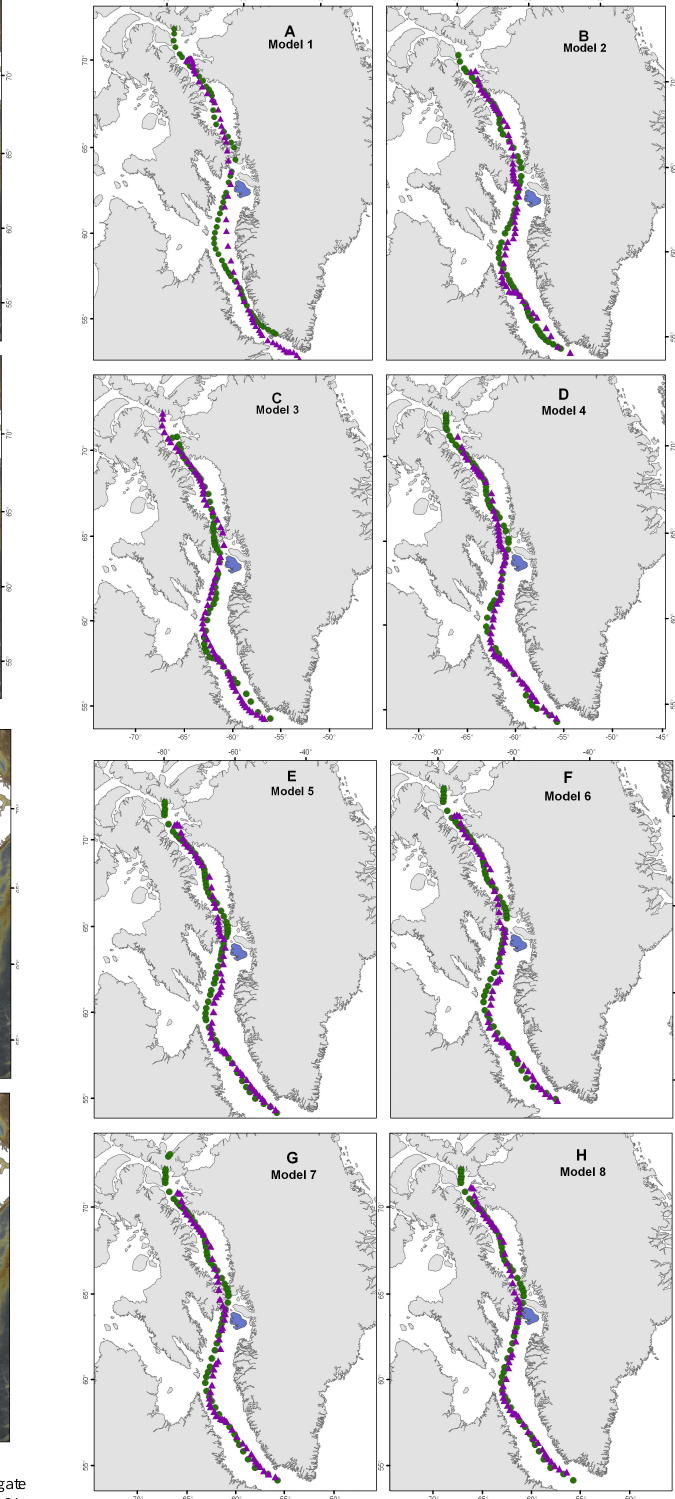
Fig. B2. Alternative full-fit (120Ma) plate reconstruction of North America– Greenland margins for all of the models tested in this study. North America restored COB has been shown in green circles while Greenland COB is shown in purple trian- gles. Disko Island is highlighted in blue in all models to make the comparison easier.